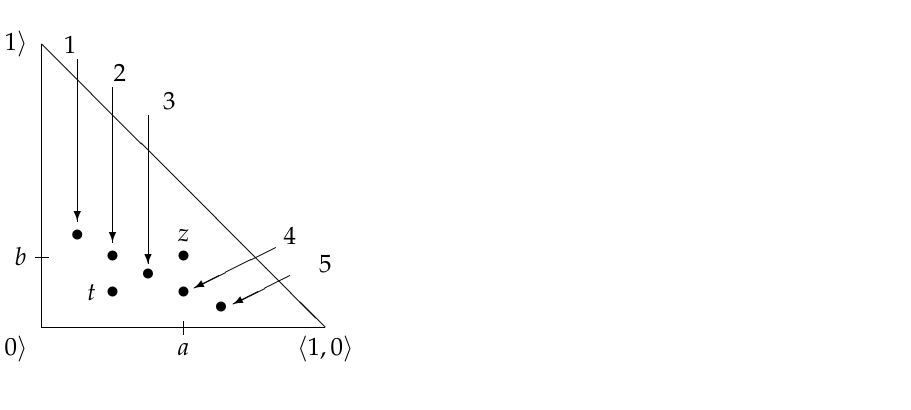
Figure 8. Geometric interpretation of the intuitionistic fuzzy pairs representing the strongly optimistic (5), optimistic (4), average (3), pessimistic (2) and strongly pessimistic (1)